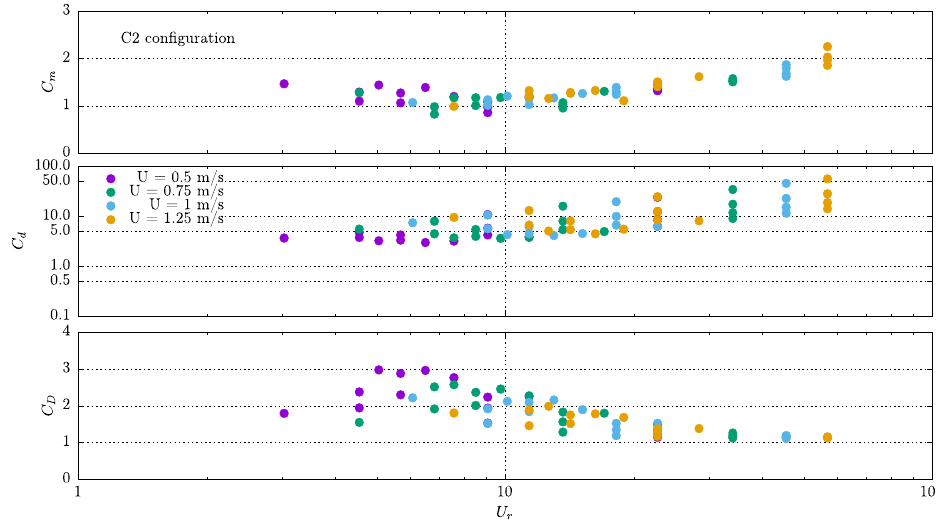
J. Mar. Sci. Eng. 2021 , 9 , x FOR PEER REVIEW Figure 12. Evolution of C m , C d and C D vs. KC for the S ( top ), C1 ( middle ) and C2 ( bottom ) cases.